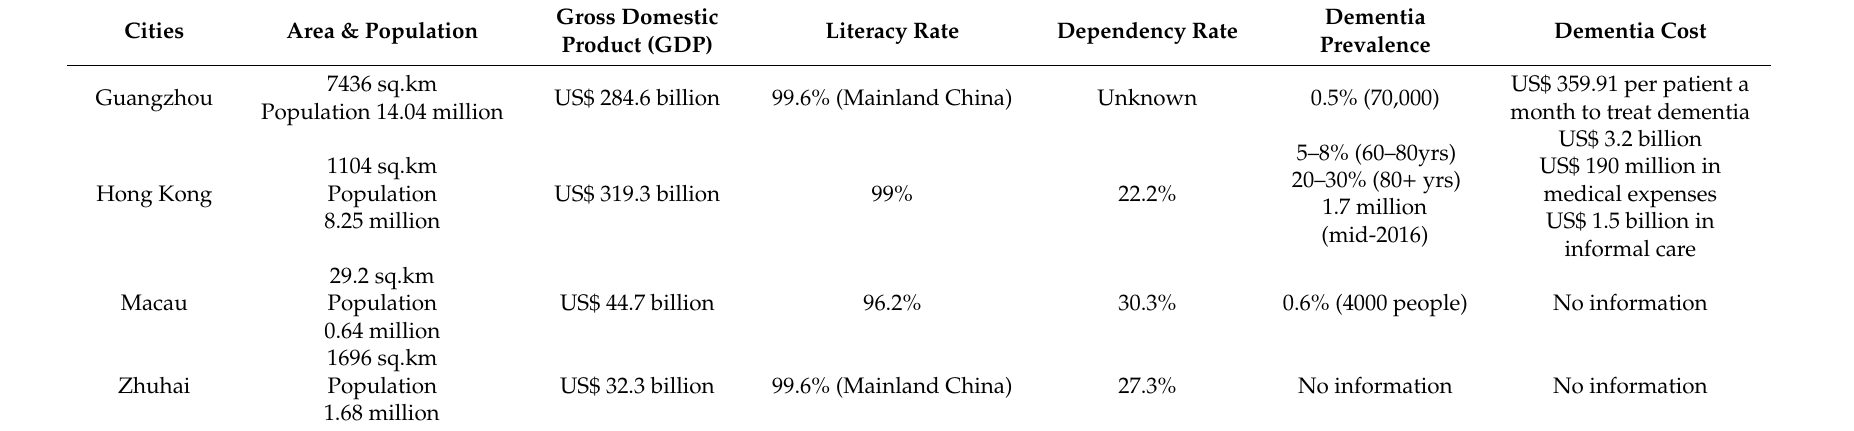
Table A1. Epidemiological data from the four cities of the Greater Bay Area of